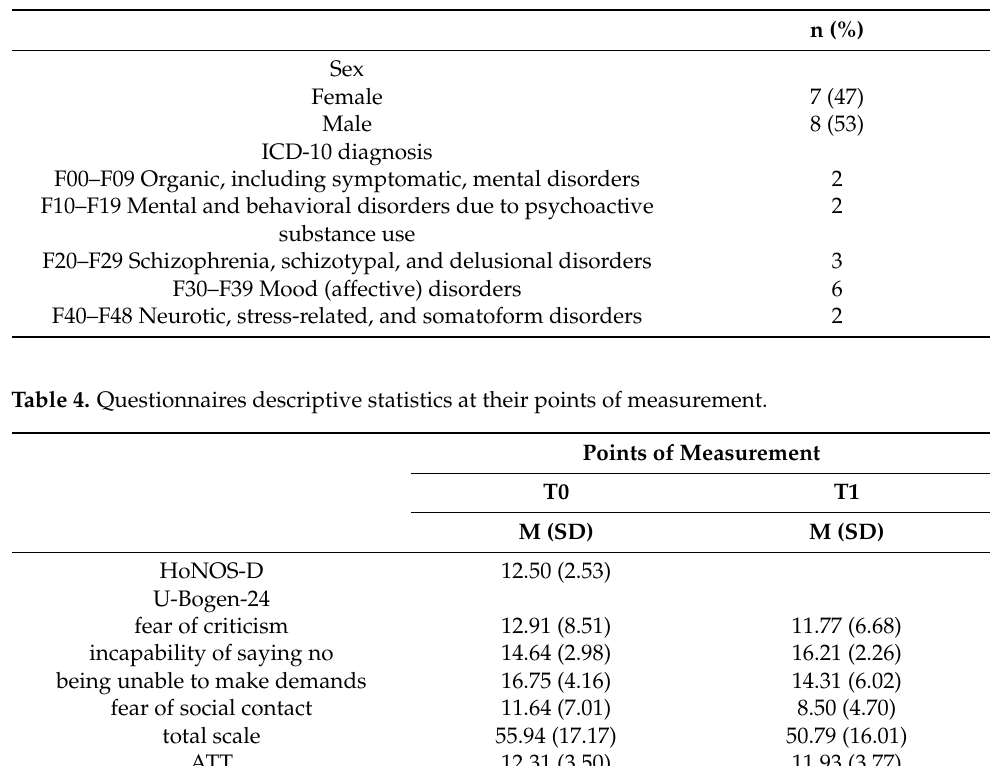
Table 3. Sample characteristics.